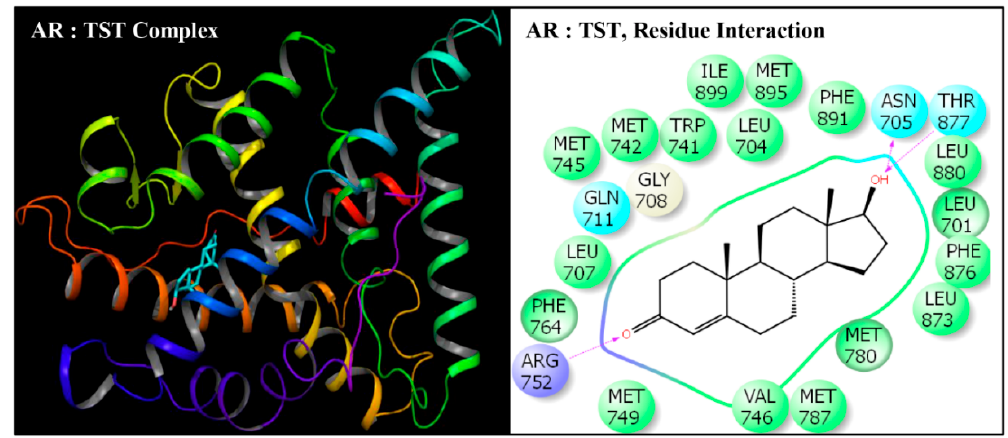
Figure 7. Ribbon diagram representing the docking pose of human androgen receptor (AR) with mono-[2-(carboxymethyl)hexyl]phthalate (2-cx-MMHP)(left panel). The interaction of ligand (2-cx- MMHP) with amino-acid residues in the binding pocket of AR (right panel).